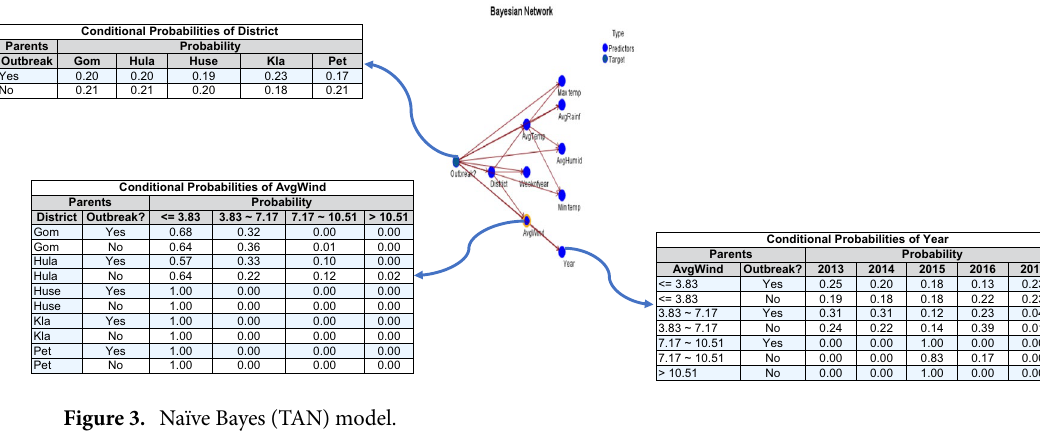
Figure 3. Naïve Bayes (TAN)